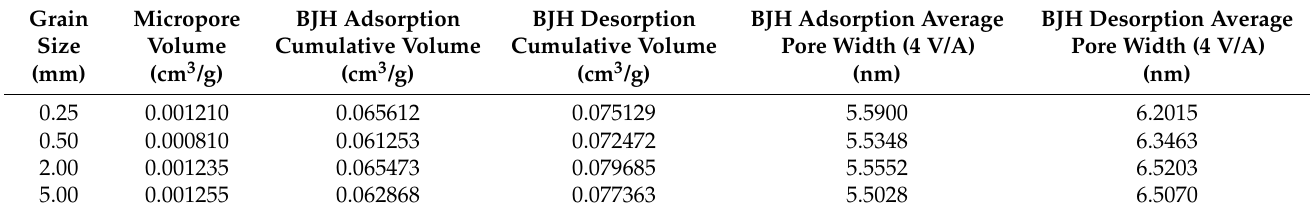
Figure 6. BJH desorption cumulative pore volume. Table 5. The pore volume of red clay with different particle sizes.